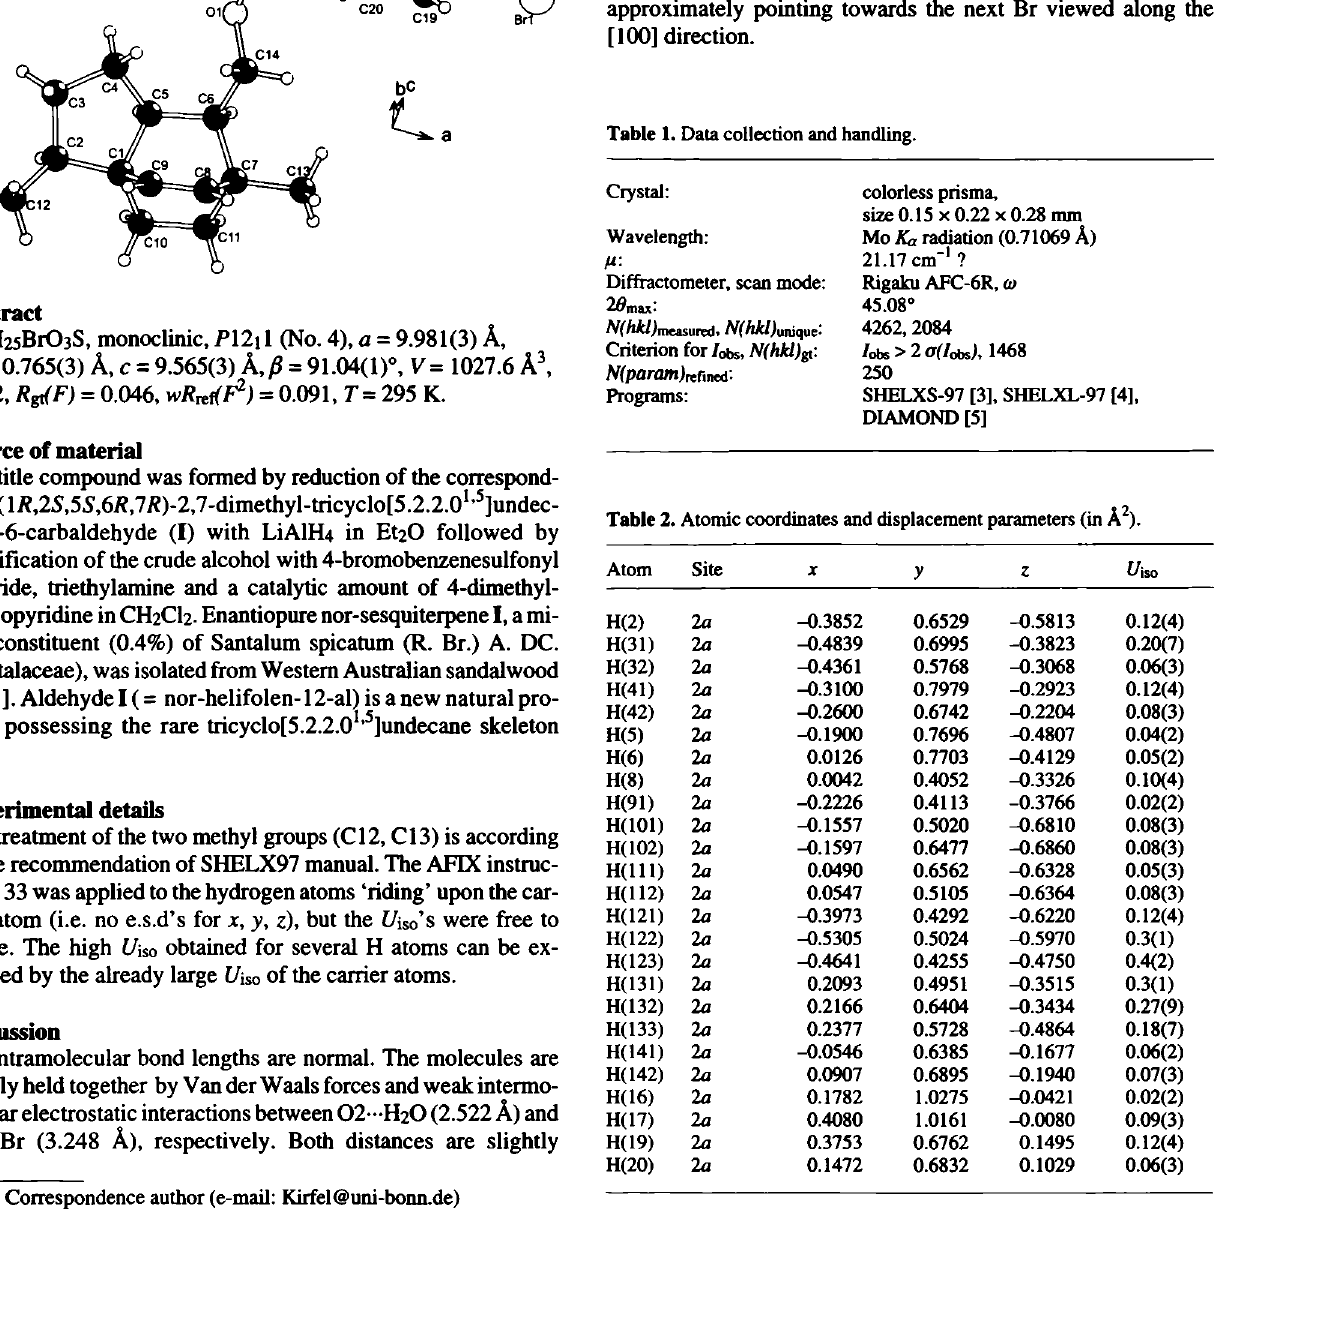
Table 1. Data collection and handling. Crystal: